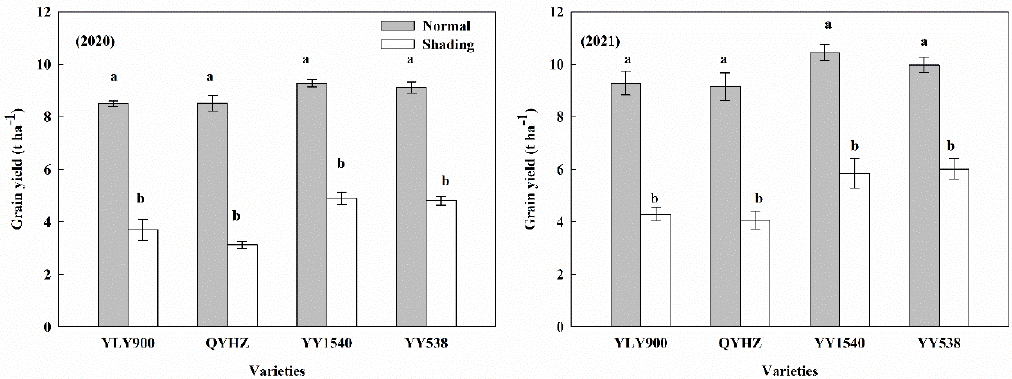
Figure 2. Grain yield of different rice varieties under shading after flowering in 2020–2021. YLY900 (Y-liangyou 900); QYHZ (Quanyouhuazhan); YY1540 (Yongyou 1540); YY538 (Yongyou 538). Different lowercase letters indicate significant differences at p < 0.05 between Normal and shading according to LSD at 0.05 level.